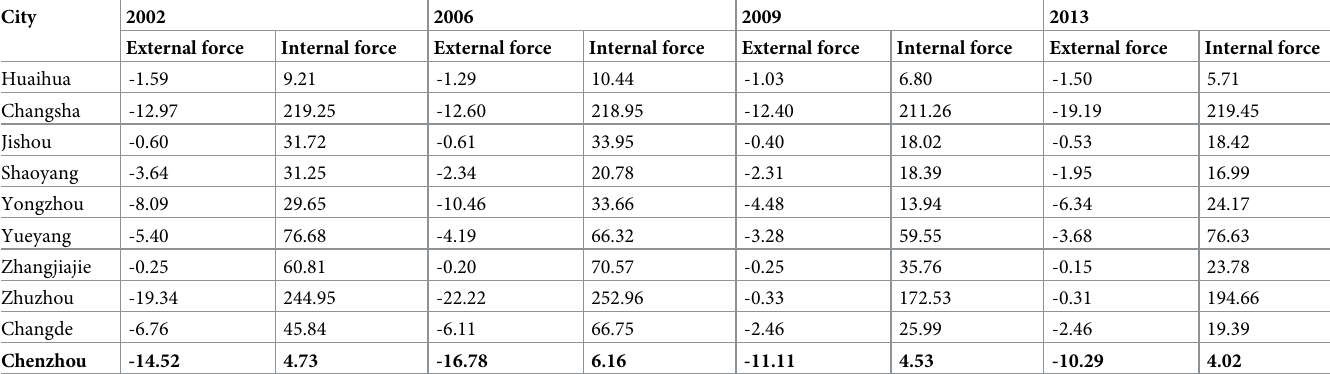
Table 2. The external and internal forces of the border city in Hunan Province.